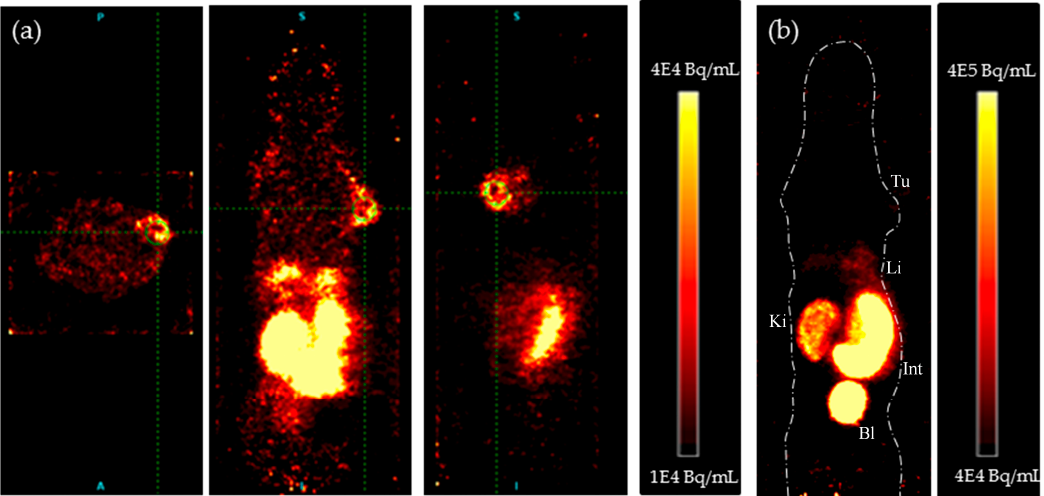
Figure 4. 18 F-DBCO-folate PET images of a KB-tumor bearing mouse (50–60 min p.i.). ( a ) representative transverse, coronal and sagittal plane with a green crosshair pointing at KB-tumor and ( b ) Maximum intensity projection. Tu = KB-tumor, Li = liver, Ki = kidney, Int = intestines, Bl = bladder.